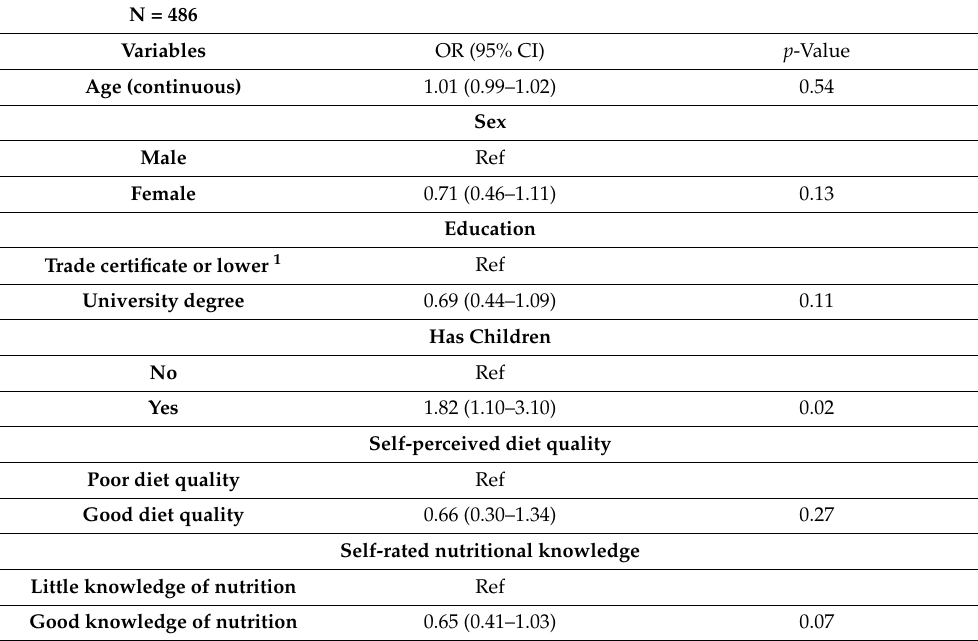
Table 3. Association between the variable “Do you think olive oil should be labelled with Nutri- Score?” (Participants who answered “no” as reference, N = 108) and socio-demographic characteristics using multi-adjusted logistic regression analyses (N =